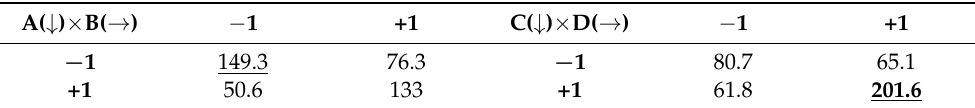
Table 7. Effect of the interactions AB and CD on the increase in weight loss evaluated by means of an adhesive wear